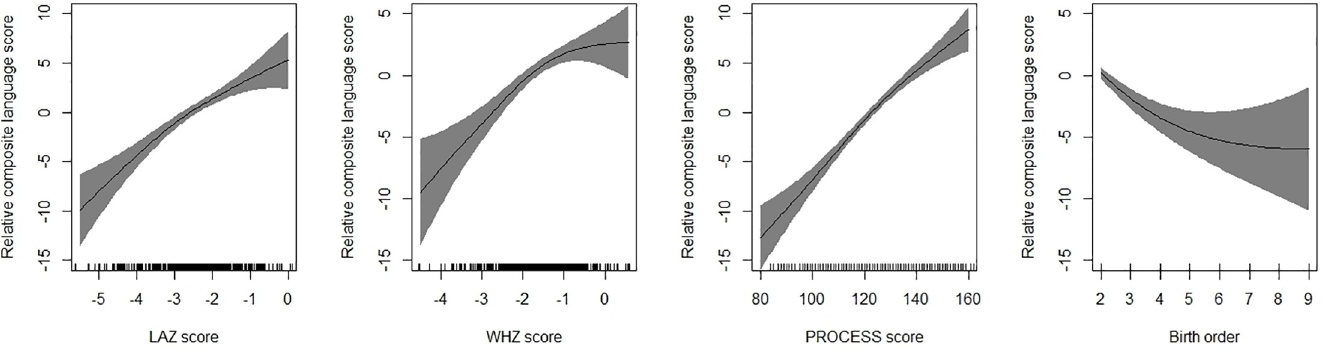
Fig 2. Associations between height for age z-scores (HAZ); weight for height z-scores (WHZ), birth order, PROCESS score and change in composite language score. The graphs were constructed using generalized additive models in R, the solid line depicts the association of composite language score and HAZ/WHZ/birth order/PROCESS score. The Y-axis is centered on the mean composite language score. The shaded area spans the 95% confidence interval of this association.